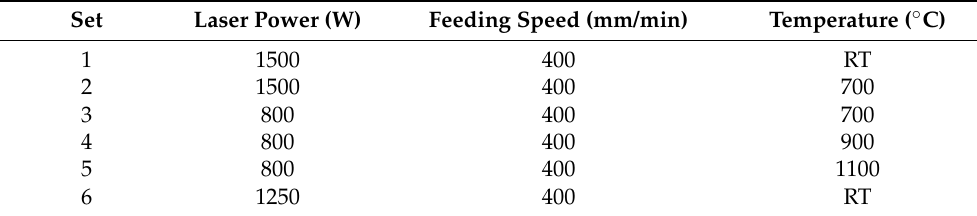
Table 4. Overview of the process parameters and pre-heating temperature for the analyzed single tracks made of pre-alloyed powder. (RT—room temperature).